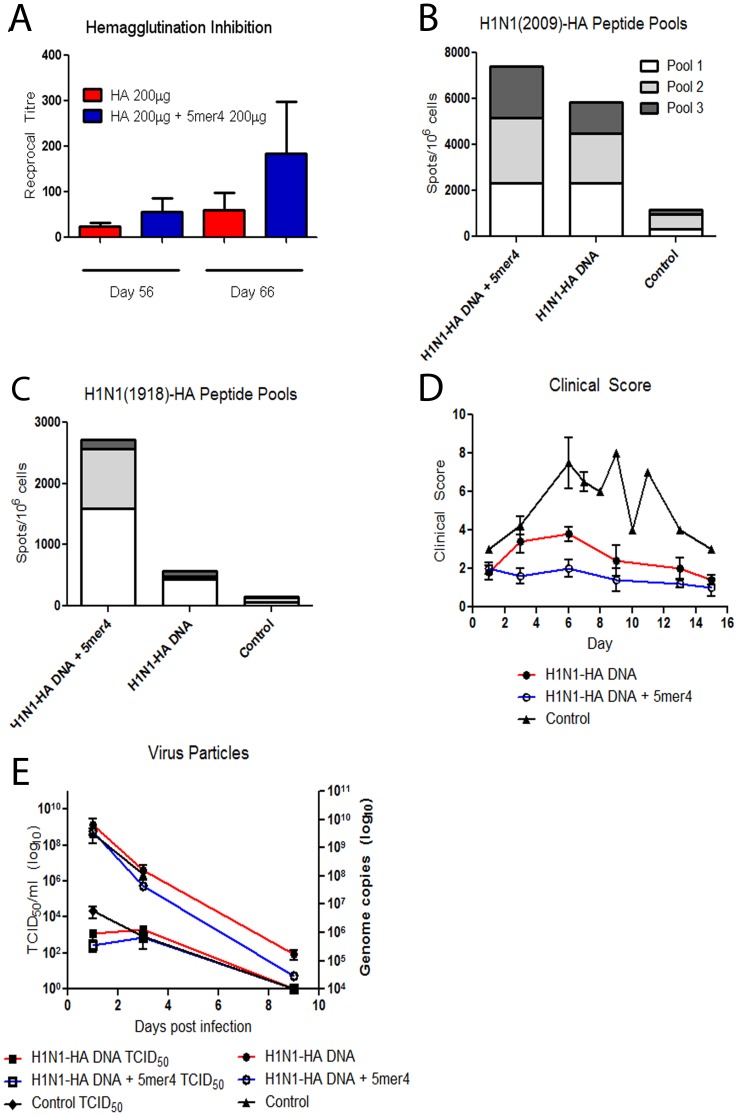
Evaluation of H1N1-HA DNA vaccine combined with exogenous 5mer4 adjuvant in ferrets.Ferrets were immunized with 200 µg of the H1N1-HA DNA vaccine with or without the 5mer4 (200 µg) adjuvant. (a) Hemagglutination inhibition antibody responses. Ferrets received immunizations with the H1N1-HA DNA vaccine, administered 3 times at one month intervals. Serum was collected after each vaccination and prior to challenge. HI antibody responses were evaluated at days 55 and day 66 post-immunization and detected using turkey red blood cells. (b) HA-specific T-cell responses. PBMCs were collected by ficoll gradient from all ferrets following challenge with the H1N1-2009 virus. T-cell responses were evaluated following re-stimulation with 3 peptide pools representing the H1N1-2009 HA protein. (c) HA-specific T-cell responses following re-stimulation with 3 peptide pools representing the H1N1-1918 HA protein. (d) Clinical observations of ferrets following H1N1-2009 challenge. Ferrets were scored on a scale of 1–10, where 0 = no signs of disease, 10 = most severe. (E) Infectious and total virus particles. Ferret nasal washes were collected at days 1, 3, and 9 following infection. Left axis: Infectious virus titre from the nasal washes of H1N1-HA + 5mer4 (□), H1N1-HA (▪), and control (♦) ferrets was detected by TCID50 assay. Right axis: Following RNA extraction, nasal wash samples were probed with H1HA specific primers using quantitative real-time RT-PCR. H1N1-HA + 5mer4 (○), H1N1-HA (•), and control (▴) ferrets. Error bars represent the SEM.